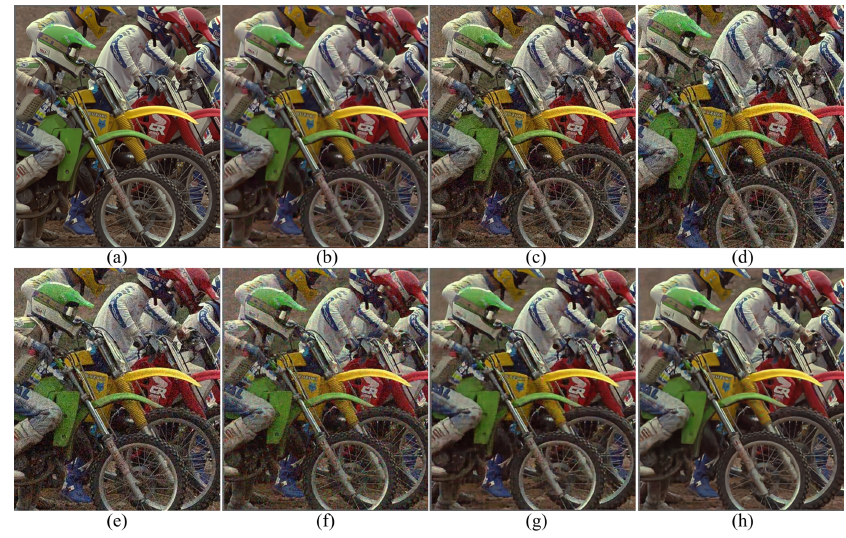
Figure 7. Enlarged regions of Figure 6. ( a ) Original, ( b ) ADMM, [28] ( c ) SEM, [14] ( d ) DNetB, [15]